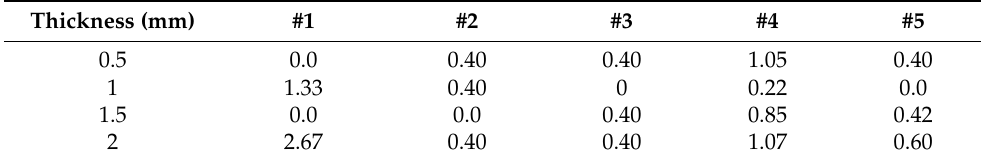
Figure 9. Damage detection results for composite materials via laser scanning. Table 2. The accuracy of surface damage coordinate detection.